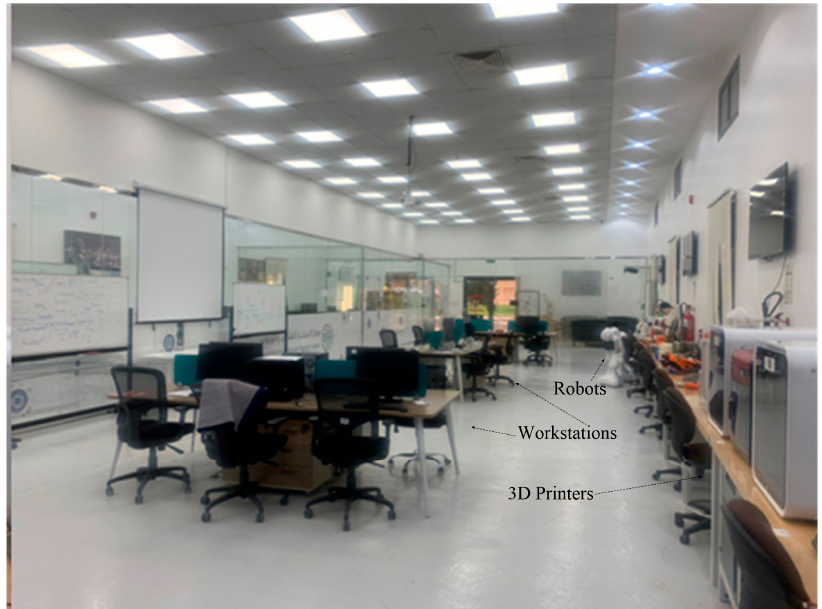
Figure 3. Side view of Area 1 (study area).